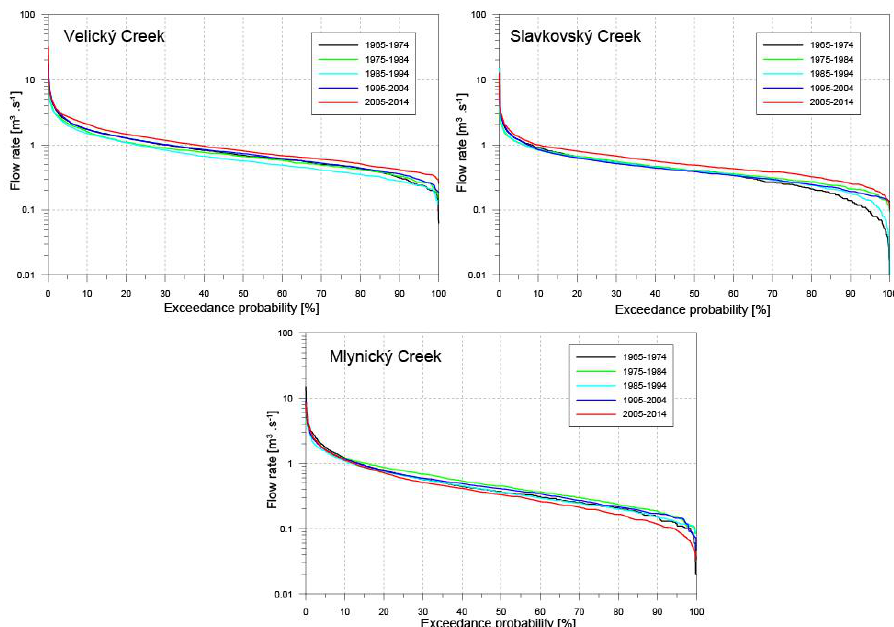
Figure 10. Median decadal flow duration curves.